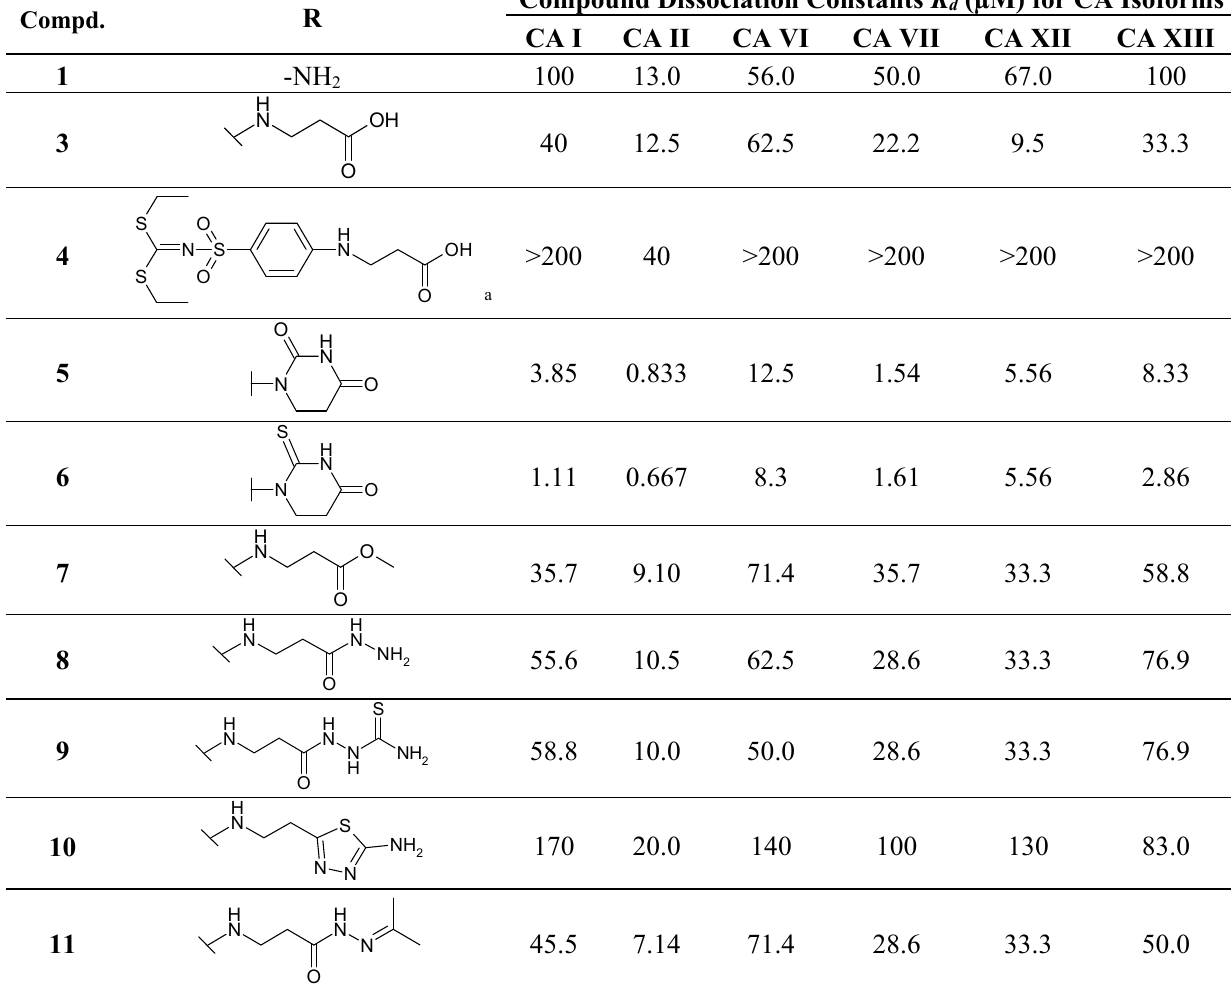
Table 1. Compound dissociation constants for six human CA isoforms, determined by the fluorescent thermal shift assay and isothermal titration calorimetry (values in the brackets) at pH 7.0, 37